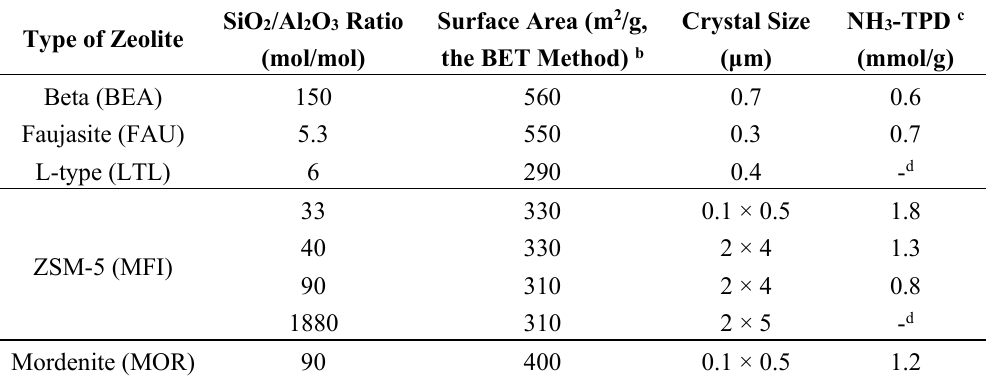
Table 1. Physico-chemical properties of zeolites used in the present experiments a